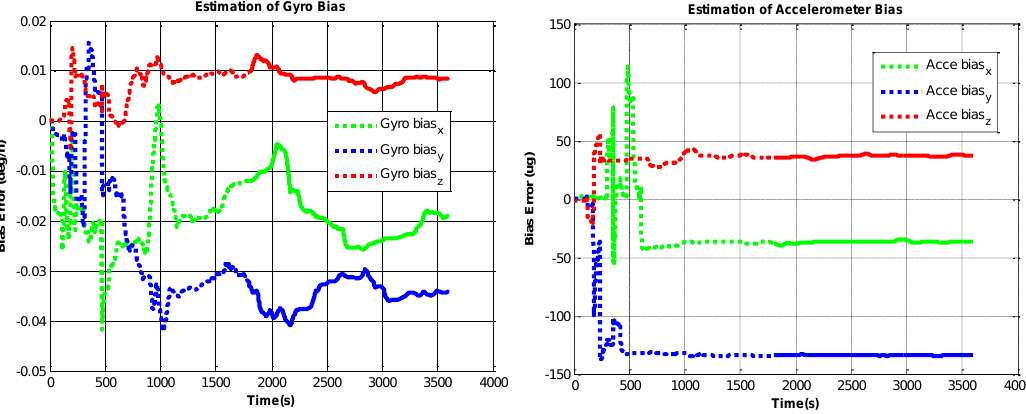
Figure 6. Estimation curves of gyroscope and accelerometer bias errors.